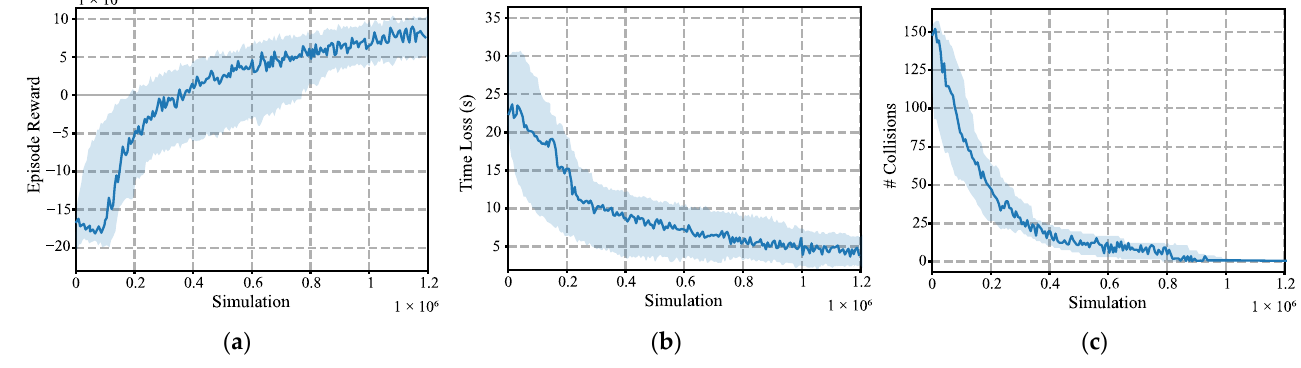
Figure 11. AIM5LA training results. The metrics show the mean (solid line) value and standard deviation (shaded area) of the 3 runs: ( a ) Average episode reward; ( b ) Time Loss (s); ( c ) Number of collisions.